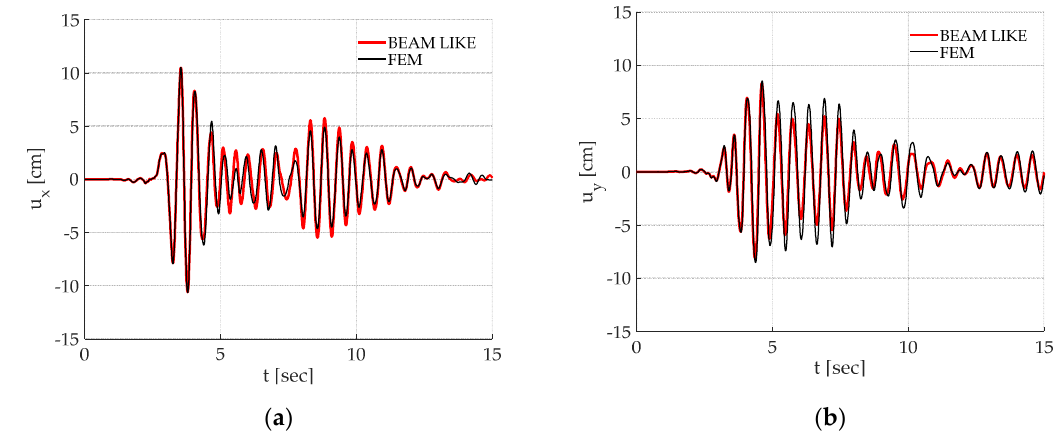
Figure 8. Four-storey benchmark. Santa Venerina earthquake. Displacements time history along the ( a ) x and ( b ) y direction.